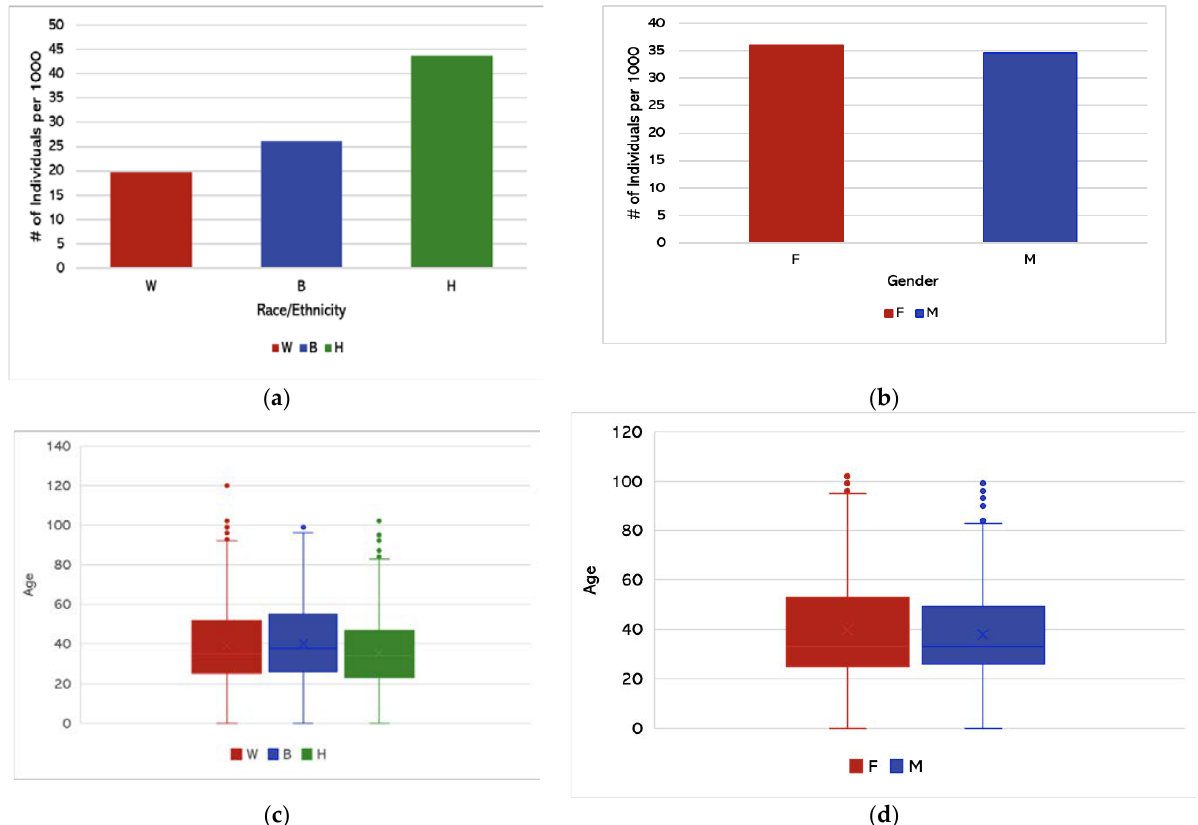
Figure 3. ( a ) Prevalence of COVID-19 cases in Kansas City with respect to race and ethnicity from March to November 2020. ( b ) Prevalence of COVID-19 cases with respect to gender from March to November 2020. ( c ) Average age of COVID-19 cases by race/ethnicity (per 1000 individuals) in Kansas City. ( d ) Average age of COVID-19 cases by gender (per 1000 individuals).